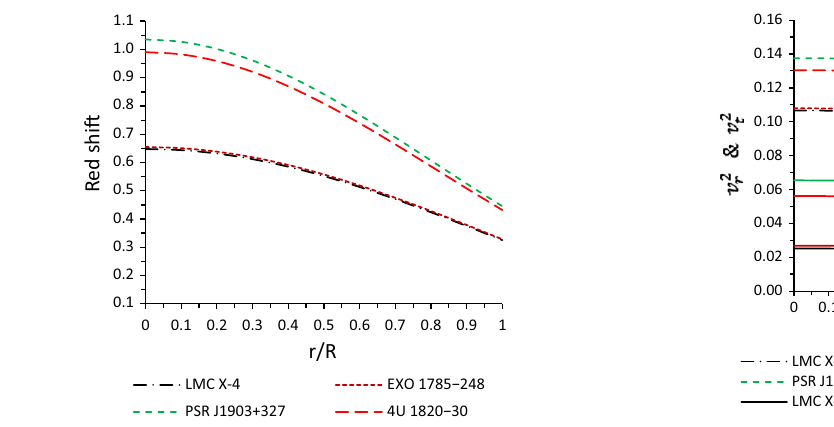
Fig. 8 Behaviour of square of radial velocity, v 2 r , ( dotted line ) and tangential velocity, v 2 t , ( solid line ) vs. fractional radius r / R for LMC X-4, EXO 1785-248, PSR J1903+327 and 4U 1820-30. For plotting this figure the numerical values of physical parameters and constants are as follows: (i) a = 0 . 004, b = 0 . 0021, c = 0 . 0107, A = 0 . 4806, B = 1 . 2607, M = 1 . 29 M (cid:7) , and R = 8 . 831 km for LMC X-4, (ii) a = 0 . 00393, b = 0 . 0025, c = 0 . 01074, A = 0 . 4905, B = 1 . 2293, M = 1 . 3 M (cid:7) and R = 8 . 849 km for EXO 1785-248, (iii) a = 0 . 005, b = 0 . 0004, c = 0 . 01481, A = 0 . 4654, B = 1 . 0551, M = 1 . 667 M (cid:7) and R = 9 . 438 km for PSR J1903+327, (iv) a = 0 . 0055, b = 0 . 0002, c = 0 . 0155, A = 0 . 44506, B = 1 . 1286, M = 1 . 58 M (cid:7) and R =